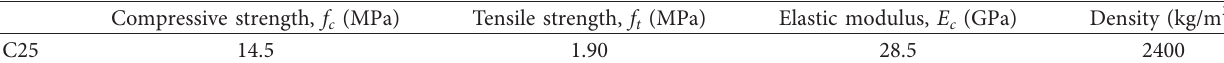
Figure 3: Cross section of the tested beams: (a) JD1; (b) JD2 (unit: mm). Table 1: Material properties of C25